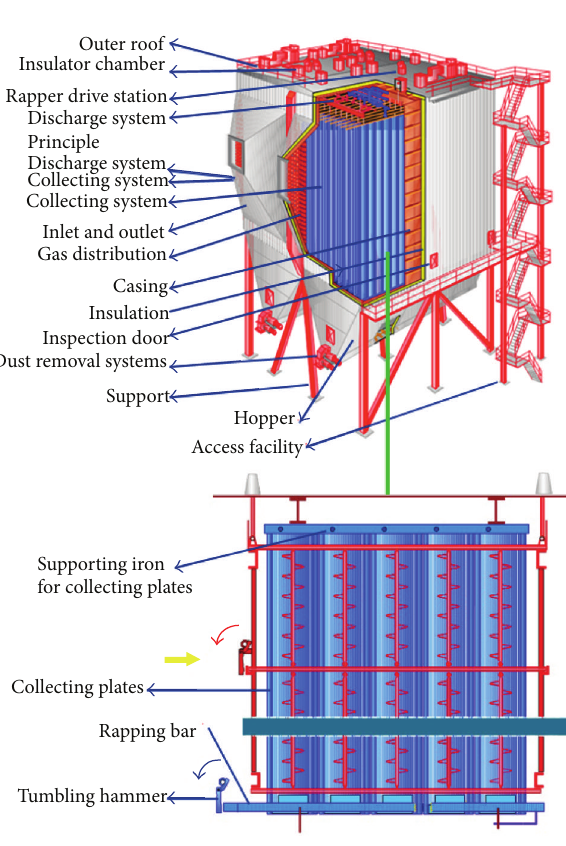
Figure 1: Electrostatic precipitator, collecting plates, and rapping system.